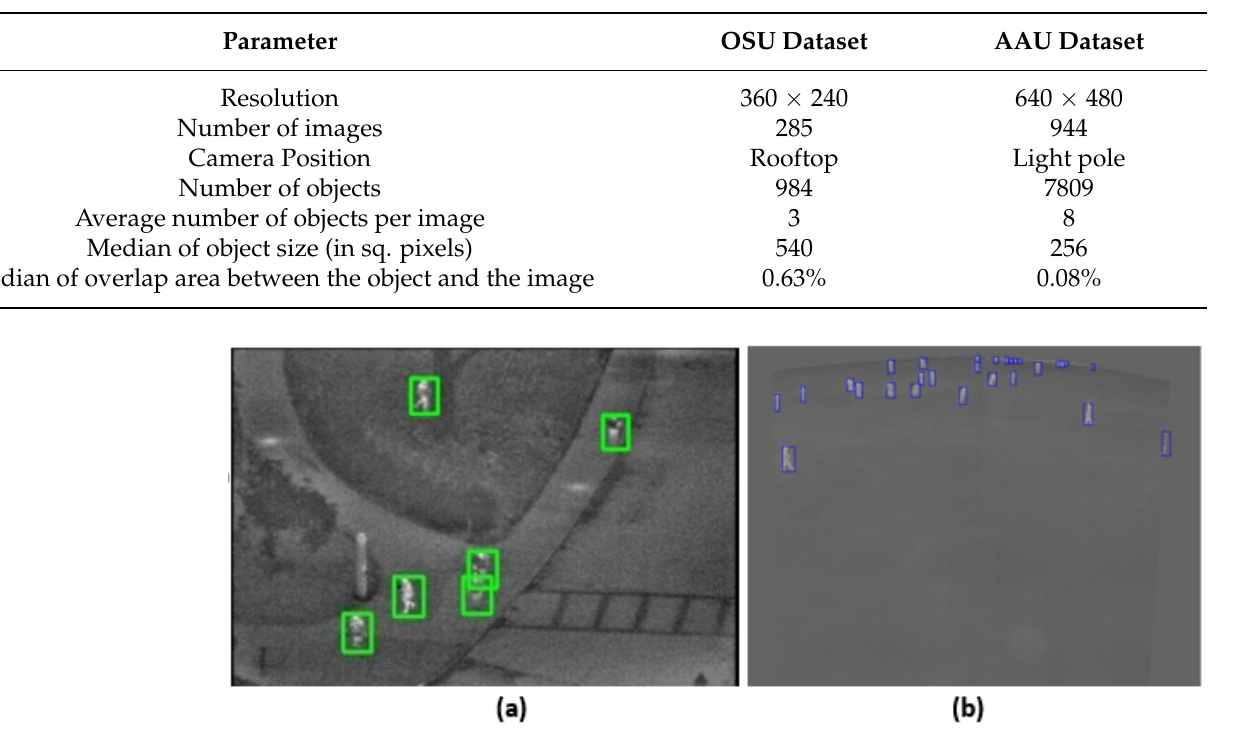
Table 1. Details regarding the dataset.